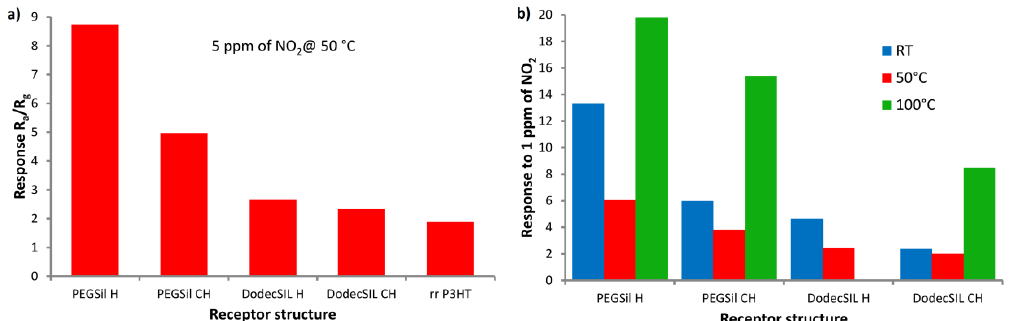
Figure 4. Summary of sensor responses to ( a ) 5 ppm of NO 2 at 50 °C, in reference to rrP3HT response taken from our previous work [18]; ( b ) 1 ppm of NO 2 at different temperatures.